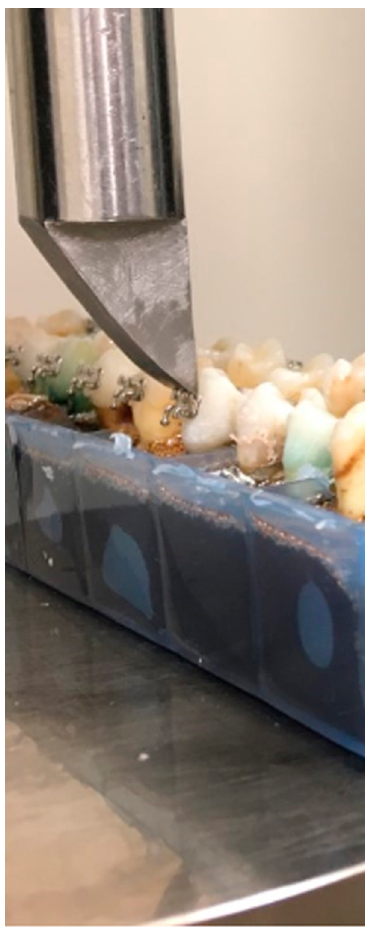
Figure 1. Instron shear bond test.